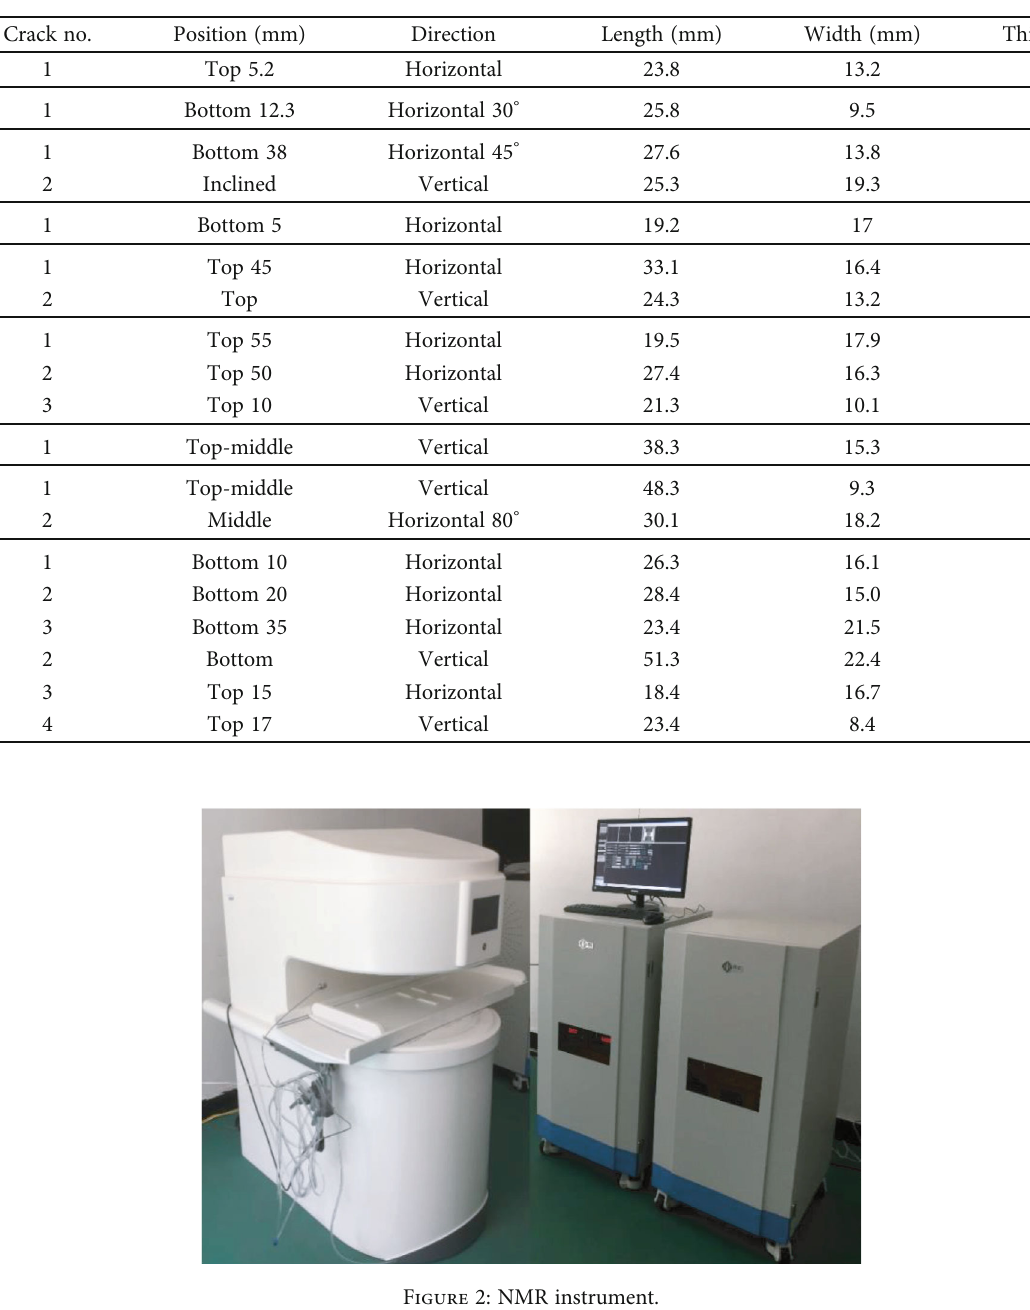
Table 2: The initial surface crack of each coal